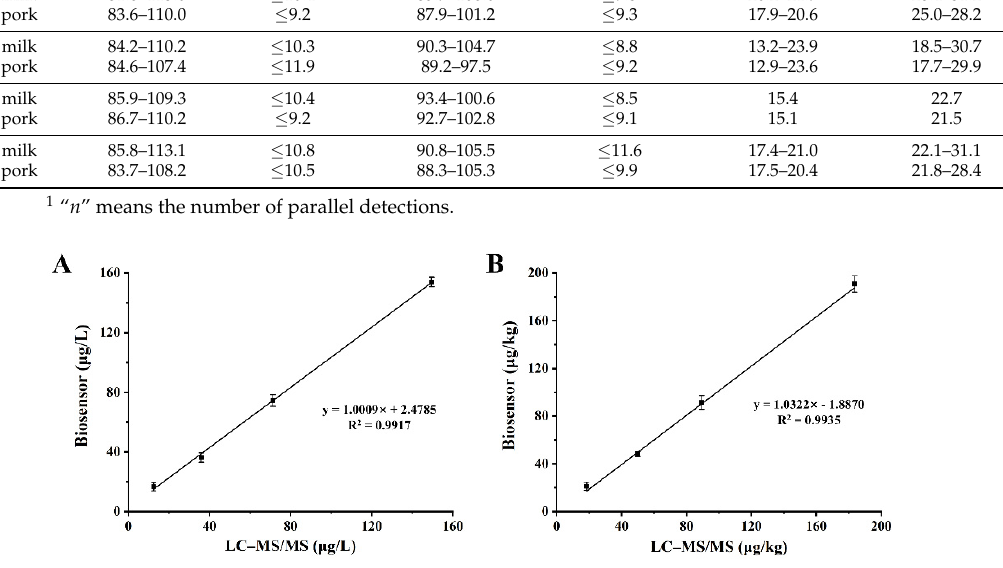
Figure 7. Correlation between the biosensor and the LC–MS/MS for analysis in milk ( A ) and pork ( B ) samples.